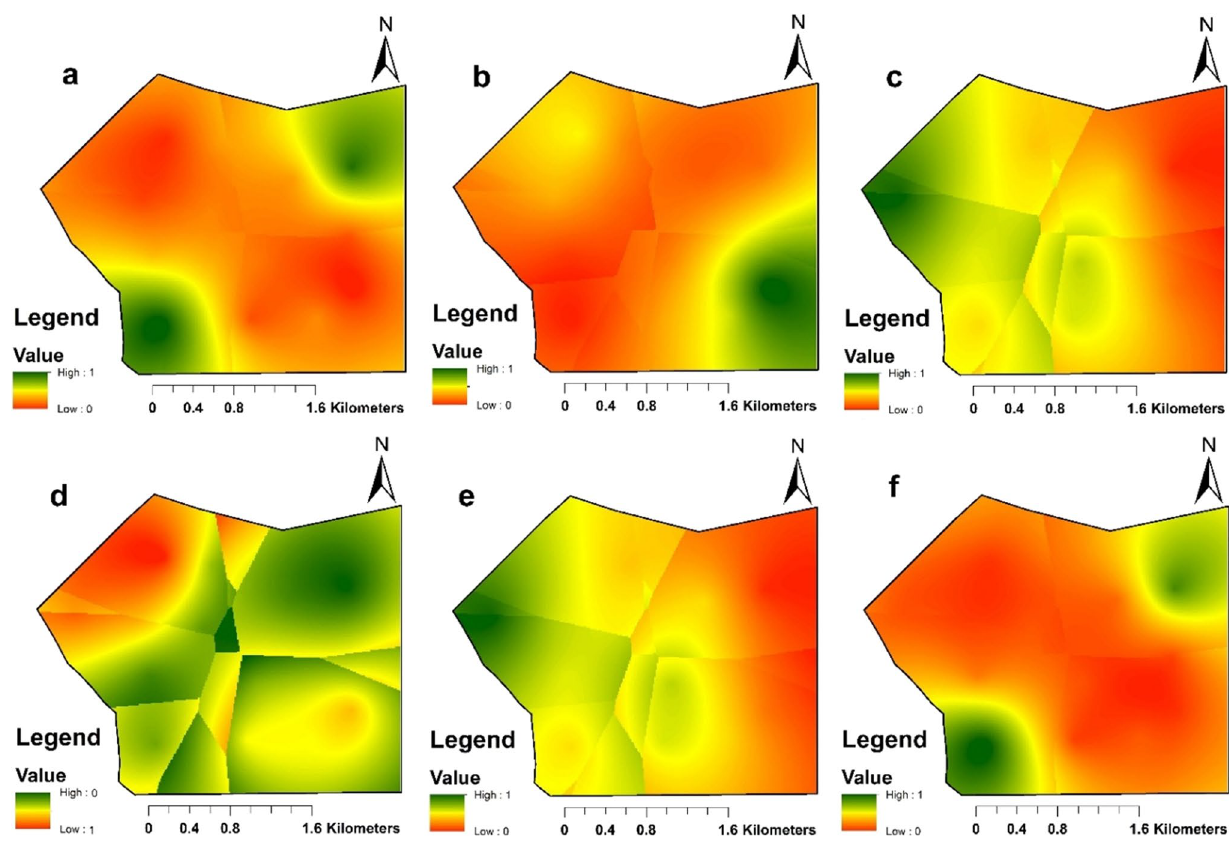
Fig. 5 Fuzzy liner membership for the criteria layers. a FLM for the porosity layer, b FLM for formation factor layer, c FLM for transmissivity layer, d FLM for longitudinal conductance layer, e FLM for thickness layer, and f FLM for aquifer resistivity layer